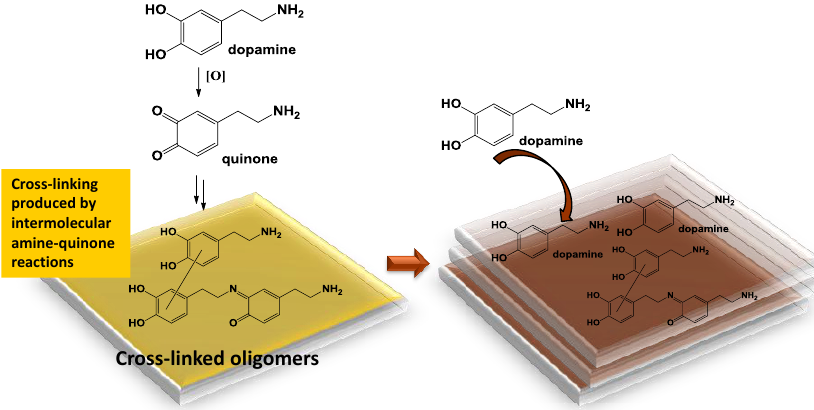
Figure 9. Schematic illustration of a possible interplay of polydopamine (PDA) film deposition (yellow) and growth pathways (red).